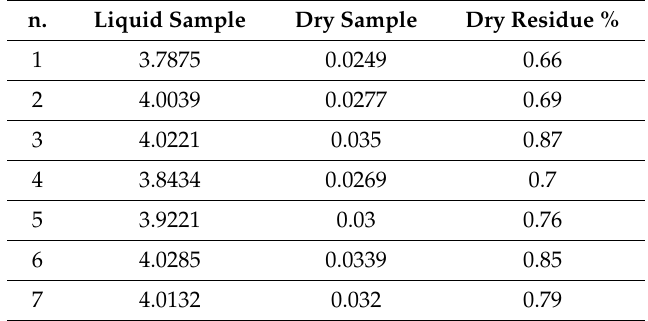
Table 2. Dry residue of the di ff erent samples and calculation of dry residue